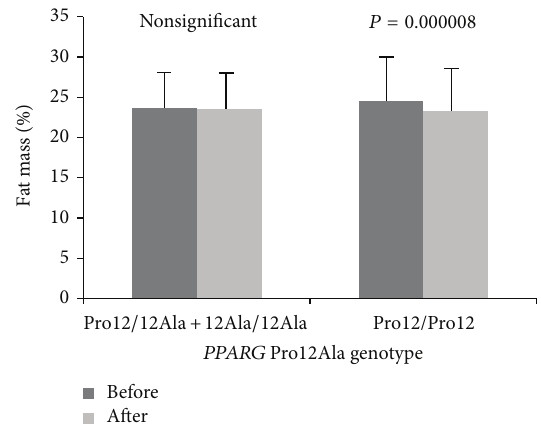
Figure 4: Changes in free fat mass (FFM) observed in participants ( PPARG 12Ala carriers versus Pro12 homozygotes) before and after the completion of 12-week training